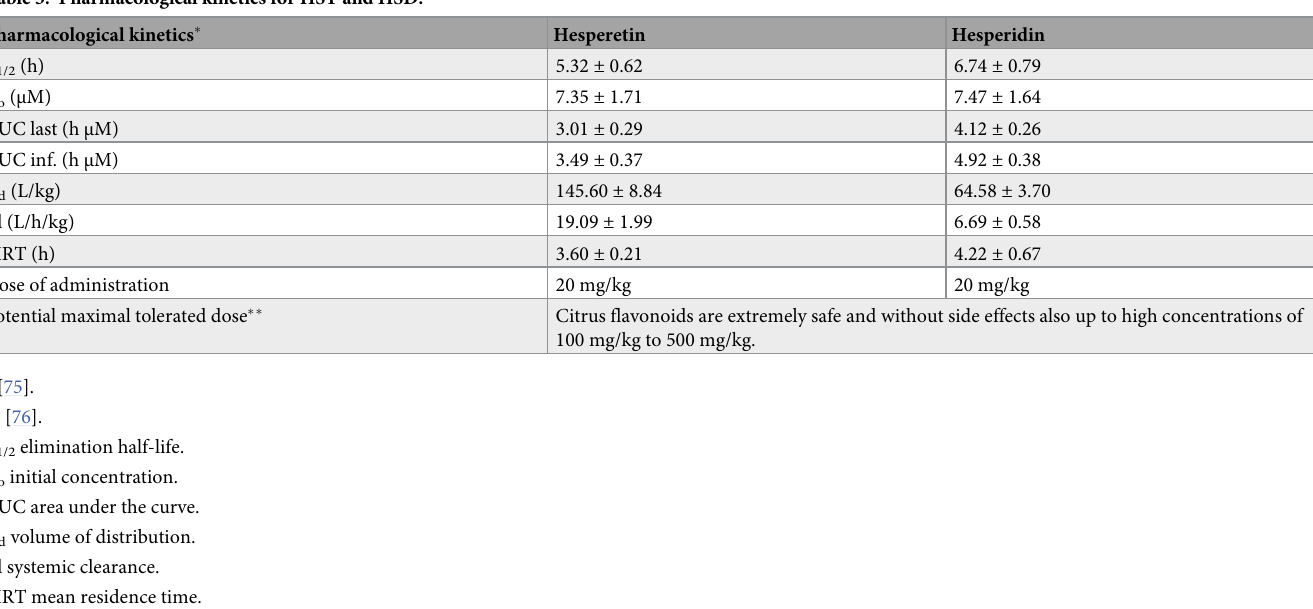
Table 5. Pharmacological kinetics for HST and HSD.